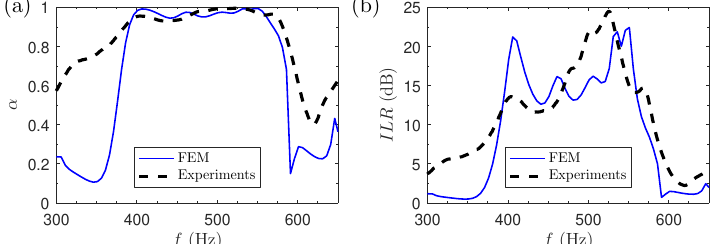
Figure 6. Anechoic chamber results: 2D system. Theoretical and experimental ( a ) absorption coefficient and ( b ) ILR, for a system composed of 5 Helmholtz resonators having the same geometry as in the 1D